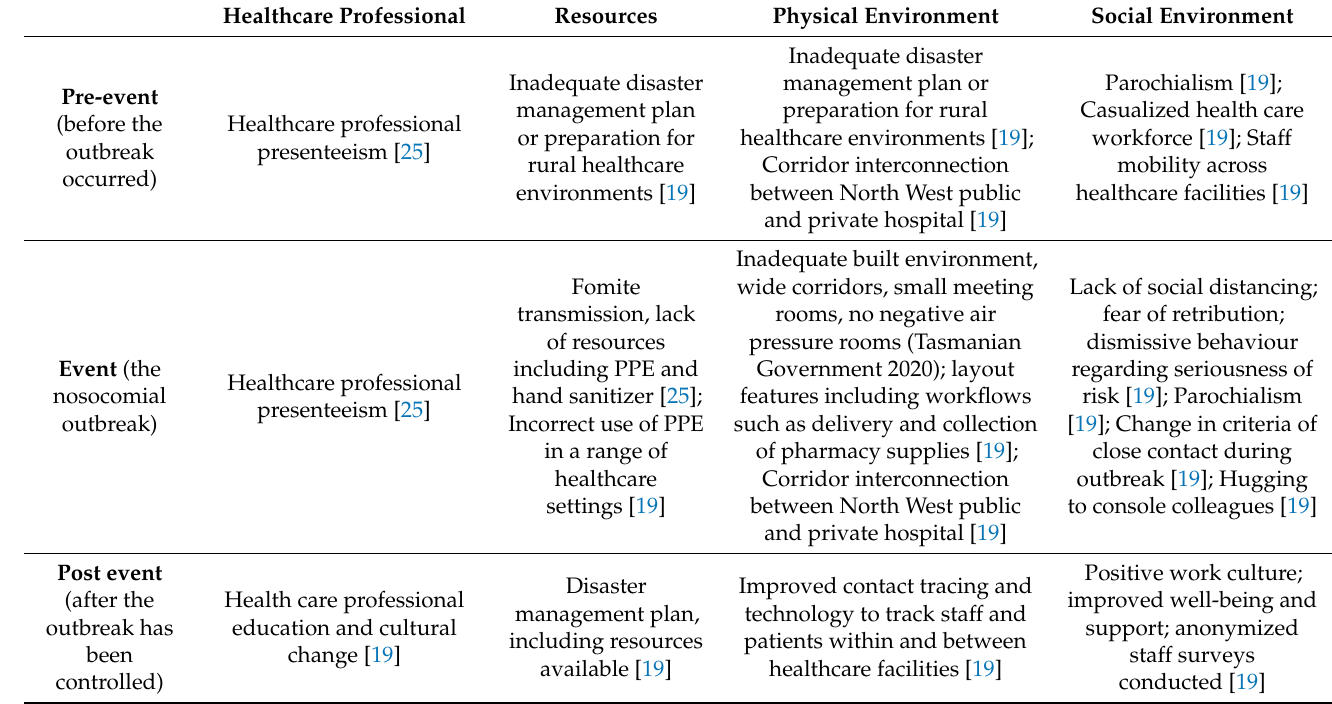
Table 1. Haddon matrix [22] demonstrating the complex of factors contributing to the nosocomial COVID-19